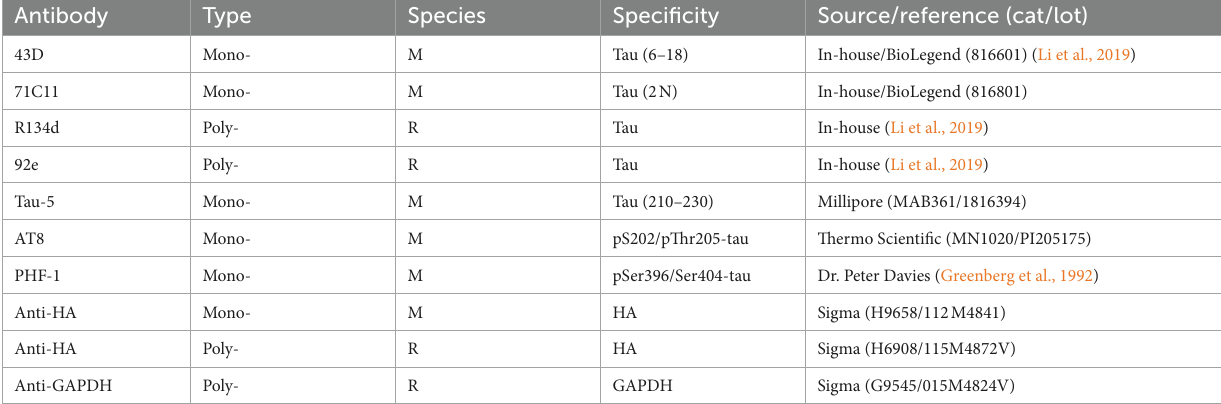
TABLE 2 Primary antibodies used in the present